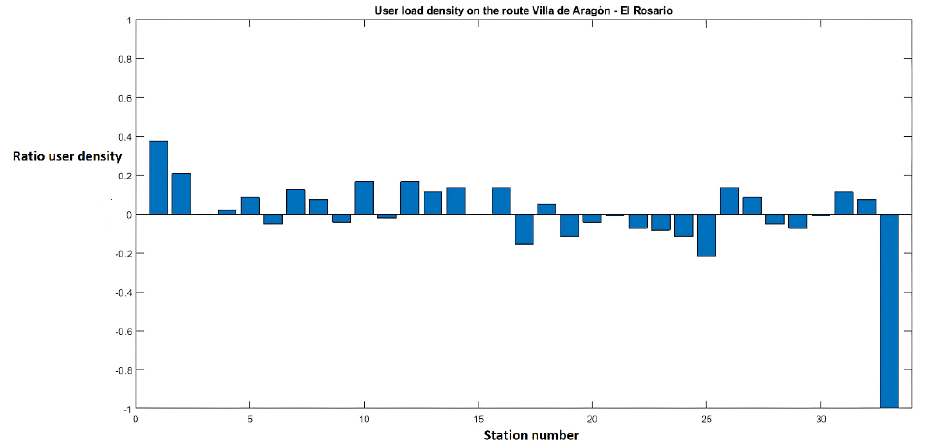
Figure 13. Density of users in a unit: ( a ) units without traffic conditions and ( b ) units under normal traffic conditions. See Table 3.